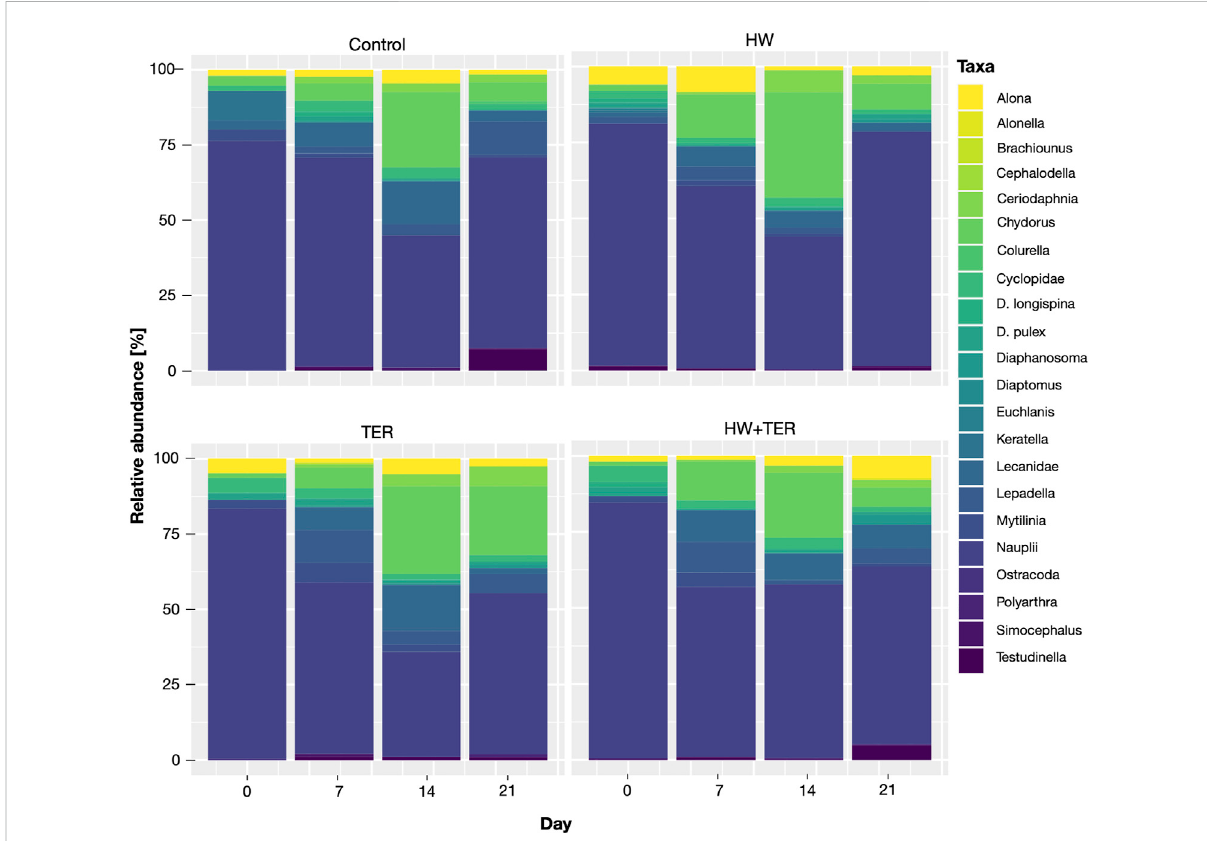
FIGURE 6 Relativeabundanceofzooplanktontaxainthetreatments(control, heatwave(HW), terbuthylazine(TER),andtheircombination(HW +TER))on each sampling day (i.e., 0 –